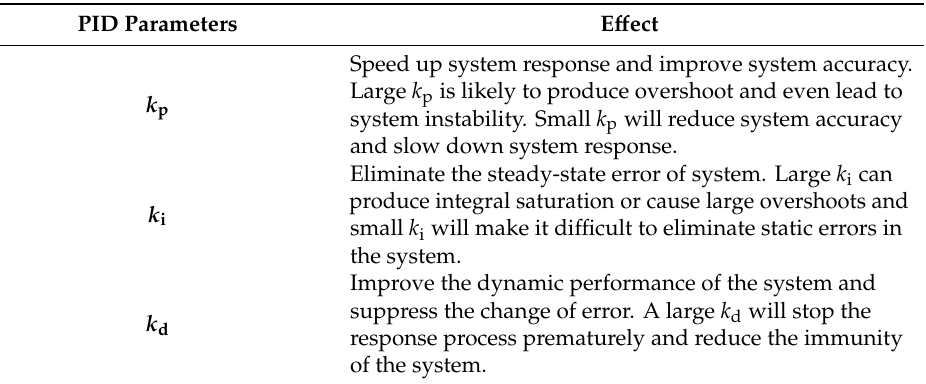
Table 2. E ff ect of PID parameters. Table 2. Effect of PID parameters.